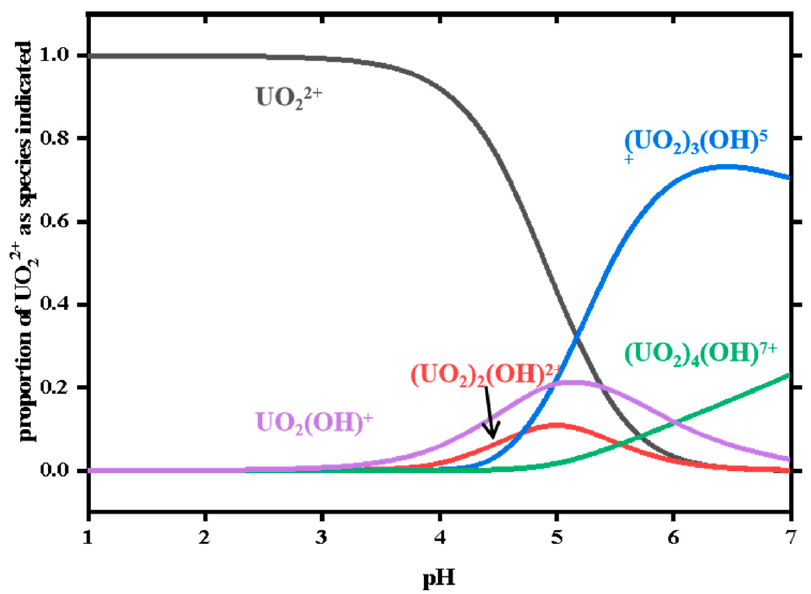
Figure 5. Ref. [17] Species distribution of uranyl ions at different pH.